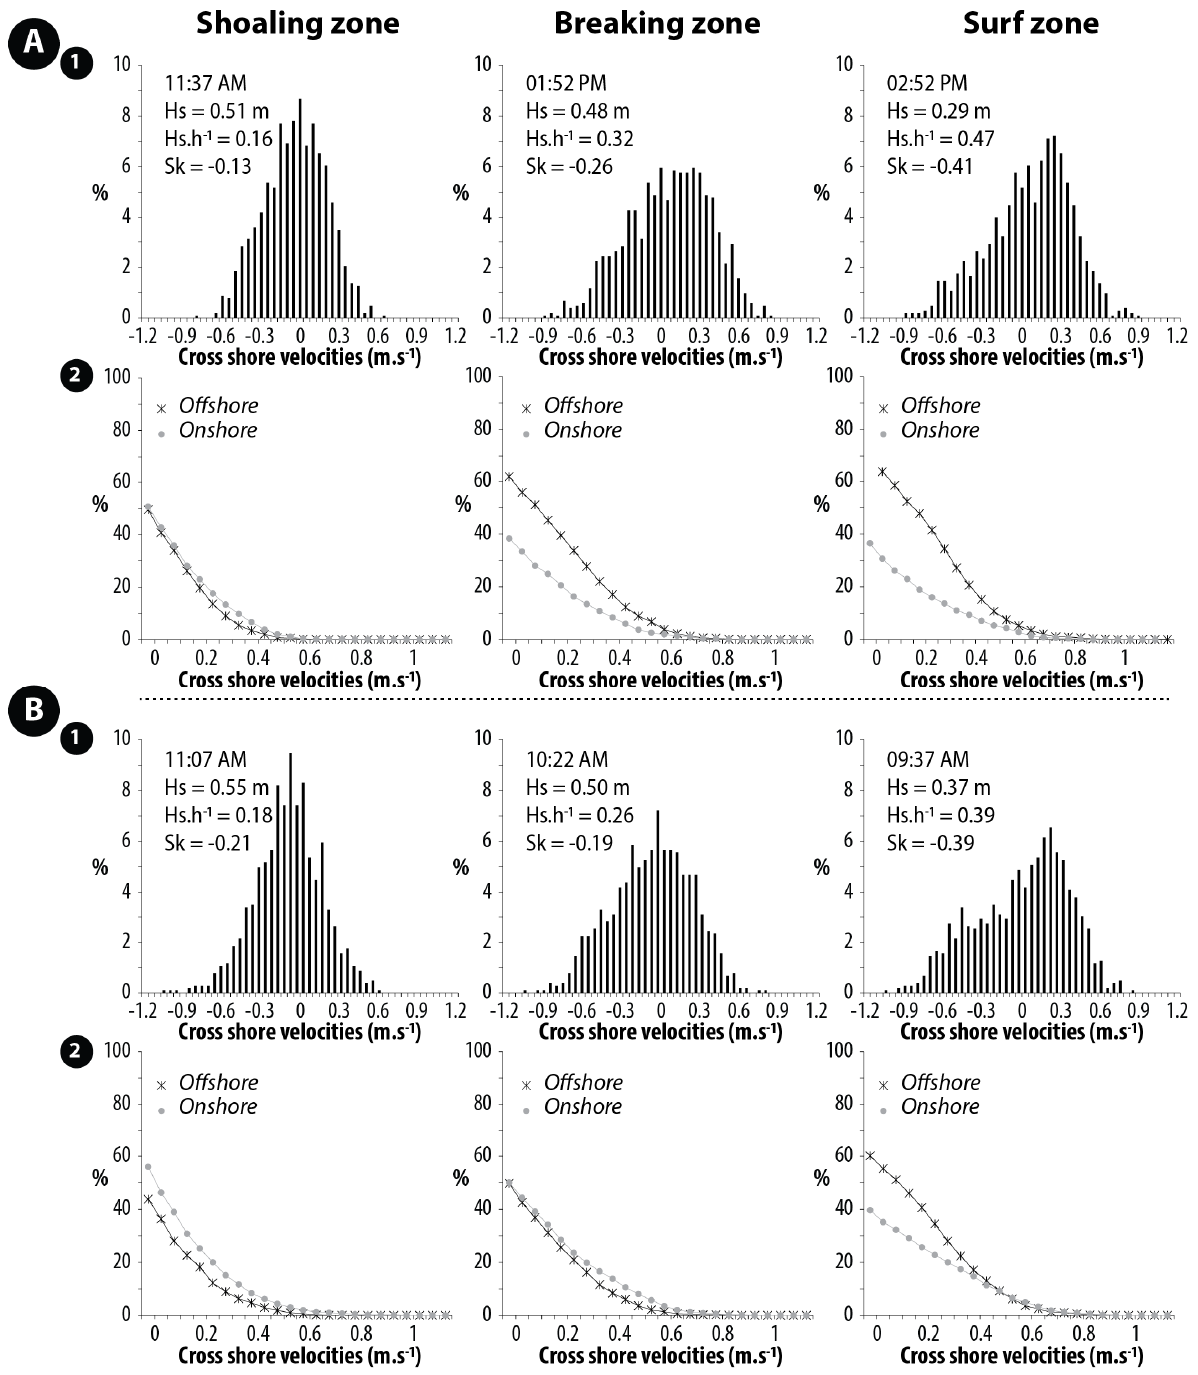
Figure 12. Examples of ( A1 , B1 ) frequency distributions of cross-shore velocities, and ( A2 , B2 ) cumulative frequency distributions of onshore and offshore velocities from current measurements recorded on bar B3 and under different wave processes (shoaling, breaking and surf). Data recorded ( A ) during falling tide on 4 June and ( B ) during rising tide on 6 June 2013. The positive and negative values of cross-shore velocities in A1 and B1 correspond, respectively, to offshore- and onshore-directed flows.